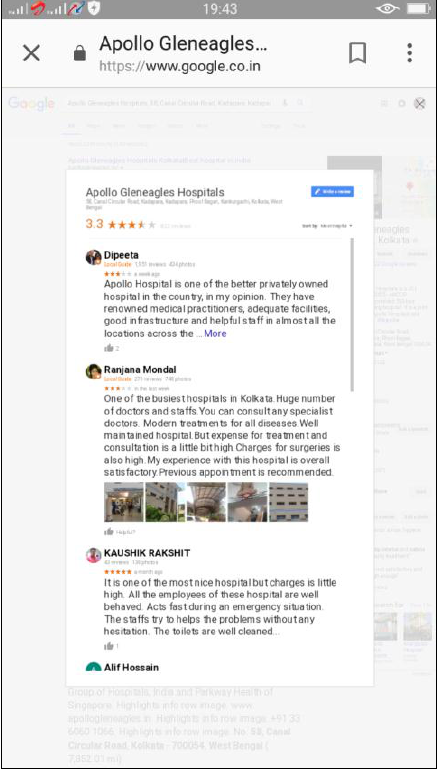
Figure 1. Google Place Reviews for Apollo Gleneagles Hospital, Search Result Page accessed on 29.01.2018 Figure 1 represents the Google Place Reviews for Apollo Gleneagles Hospital Kolkata. Review contains mean